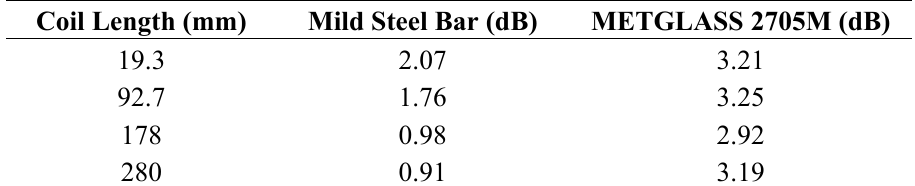
Table 3. Transducer thresholds for different coils.